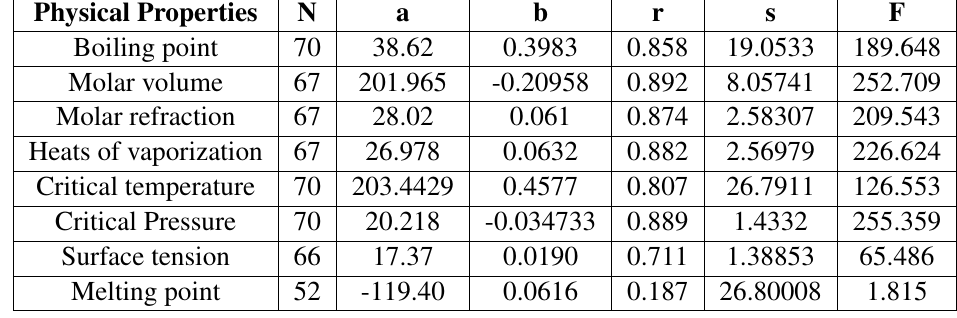
Table 7. Statical parameters for the linear QSPR model for Gutman index.